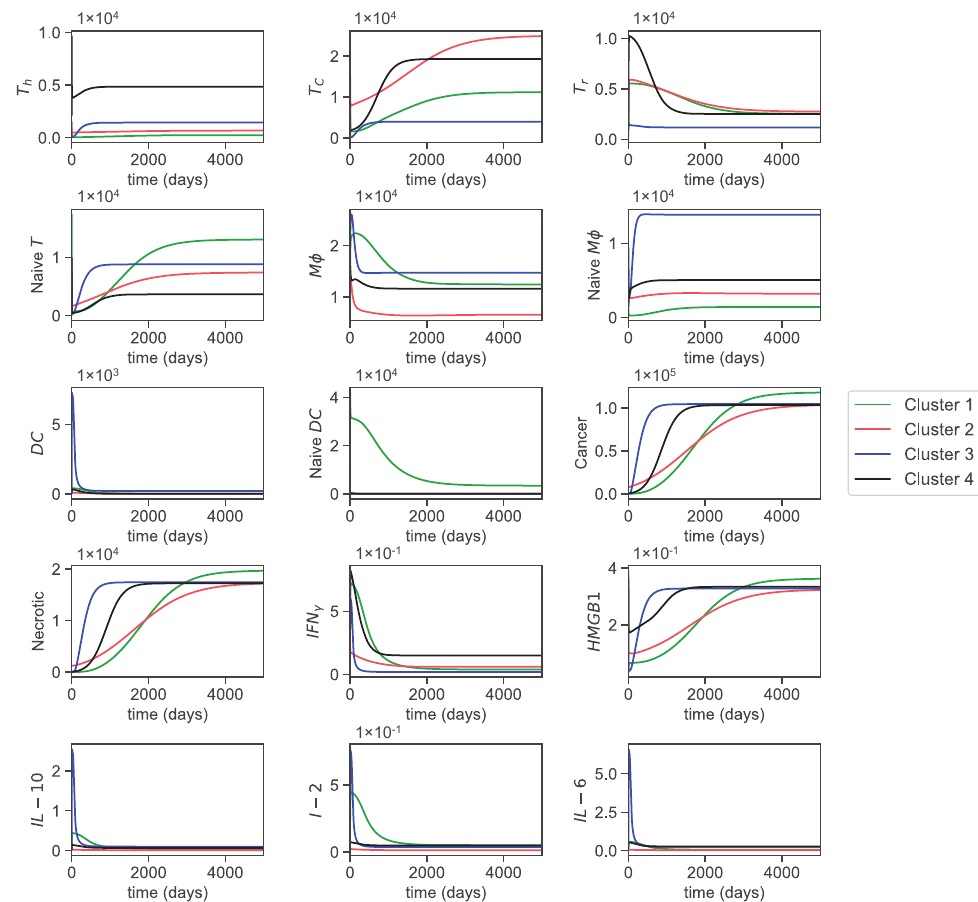
Figure 3. Dynamics of all variables over 5000 days.